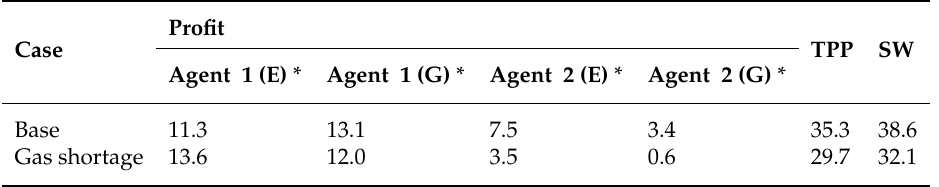
Table 2. Example: profits and social welfare ($ thousand) for two cases (Max Total Producers’ Profit (TPP) Equilibrium Problem with Equilibrium Constraints